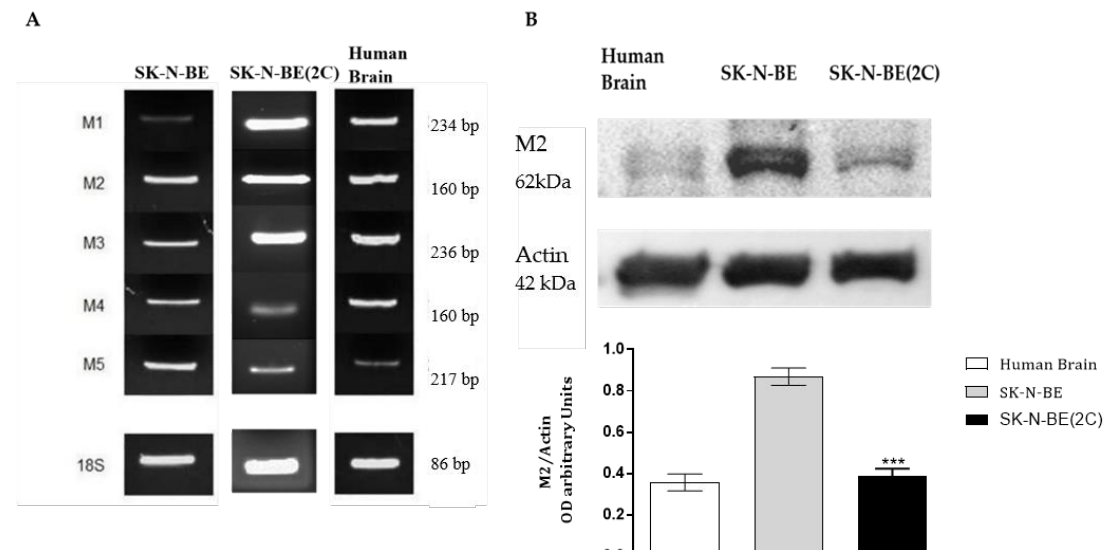
Figure 1. ( A ) RT-PCR analysis for all five muscarinic receptor subtypes in SK-N-BE and SK-N-BE(2C). The resistant cell line shows major expression of the odd muscarinic receptors M1 and M3. Here, 18S was used as housekeeping gene. Human brain was used as positive control. ( B ) Representative Western blot showing M2 muscarinic receptor expression in SK-N-BE and SK-N-BE(2C) cell lines. β-actin was used as protein reference. Protein extract from human brain was used as positive control. The graph below reports the densitometry of the bands for the M2 receptor protein normalized with the protein reference (actin). The data are the average of three independent experiments (*** p < 0.001, t -test; SK-N-BE(2C) vs. SK-N-BE).